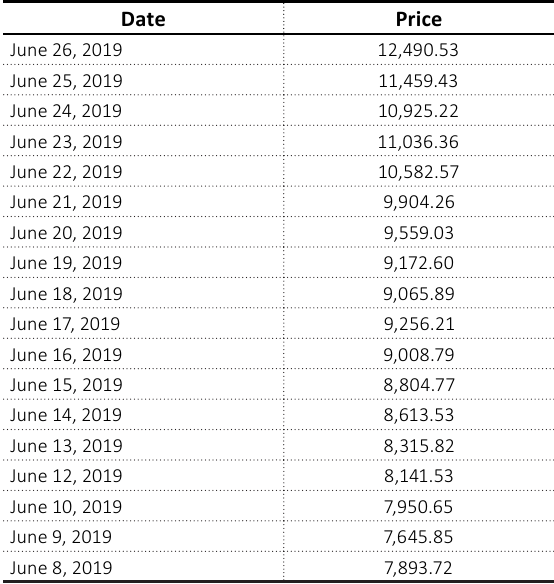
Source: ElEconomista.es